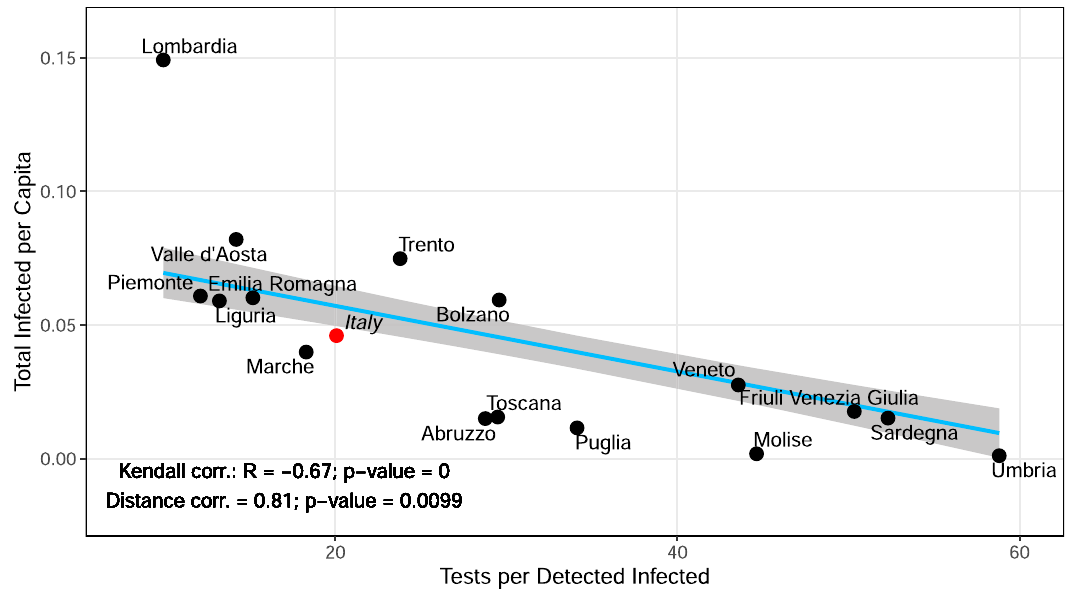
Fig. 3 Impact of tests on the total infections. Kendall and distance correlation between the number of tests performed per infection and total infections per capita. By considering 16 regions and Italy, a signi fi cant negative correlation con fi rms that the infection dynamics can be controlled by aggressive testing, which is further supported by the infection epidemic curve in Fig. 4a. Data are considered up to April 15 th . Light blue line: linear regression fi t; gray shaded area: standard error; black dots: region-speci fi c values; red dot: nationwide value; R : correlation coef fi cient; p : signi fi